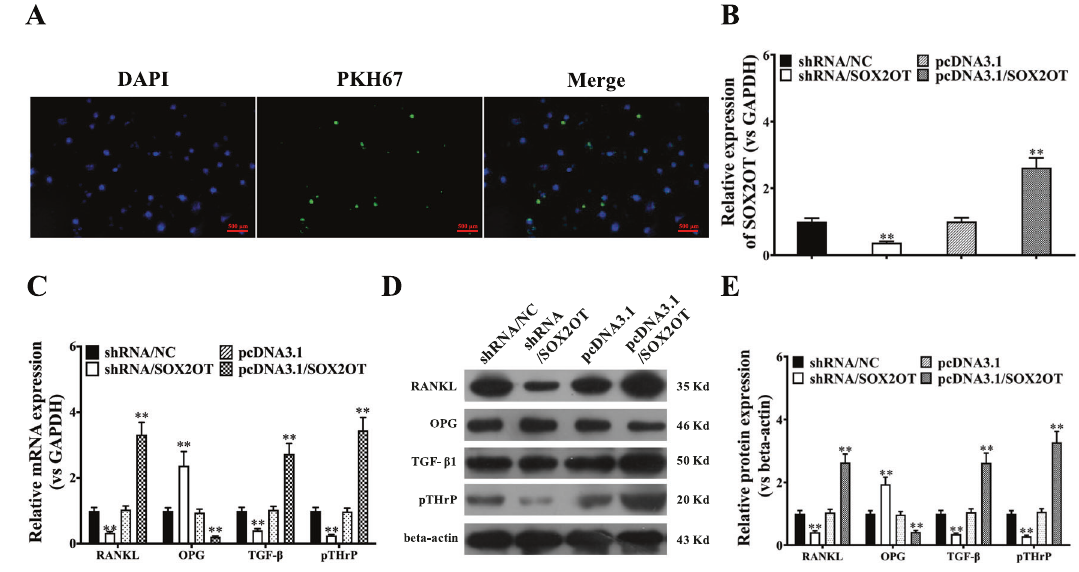
Fig. 3 LncRNA-SOX2OT-enriched exosomes regulate the expression of RANKL, OPG, TGF- β 1 and pTHrP. A To con fi rm that the exosomes could be taken up by recipient cells, the A549 cell-derived exosomes were stained with the red fl uorescent dye PKH-26 at 37 °C for 1 h, washed with phosphate-buffered saline (PBS), followed by centrifugation at 110,000 × g and 4 °C for 70 min to remove the residual PKH-26 dye. RAW264.7 cells were co-incubated with PKH67-labelled exosomes (green) derived from A549 cells. Scale bar, 500 μ m. B Real-time PCR assay detected the level of lncRNA-SOX2OT in RAW264.7 cells pre-treated with exosomes derived from A549 cells with different lncRNA-SOX2OT expression levels. GAPDH was used as the internal control. C Real-time PCR assay measured the mRNA expression of TGF- β , pTHrP, RANKL and OPG in RAW264.7 cells treated with exosomes from lncRNA-SOX2OT-knockdown or lncRNA-SOX2OT-overexpressing A549 cells. GAPDH was used as the internal control. D , E Western blot assays were performed to measure the protein expression of TGF- β , pTHrP, RANKL and OPG in RAW264.7 cells treated with exosomes from lncRNA-SOX2OT-knockdown or lncRNA-SOX2OT-overexpressing A549 cells. Beta-actin was used as a referred protein. *, P < 0.05; **, P < 0.01 (t